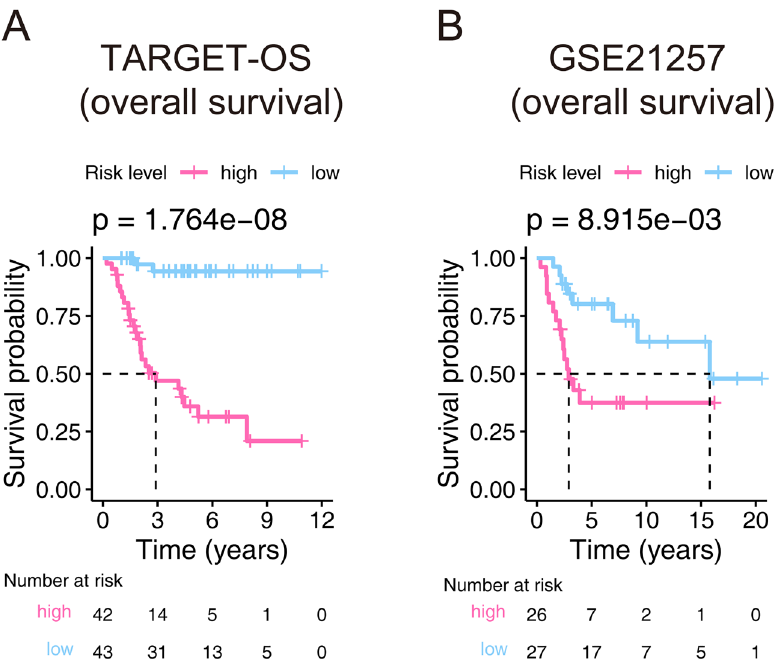
Figure 4. Kaplan–Meier estimator that evaluating the prognosis capacity of the seventeen-gene signature in the training ( A ) and validation ( B ) cohorts. The bottom part indicates the number of patients at risk. The two-sided log-rank test measured the differences between the high- and low-risk groups with a p value < 0.05.